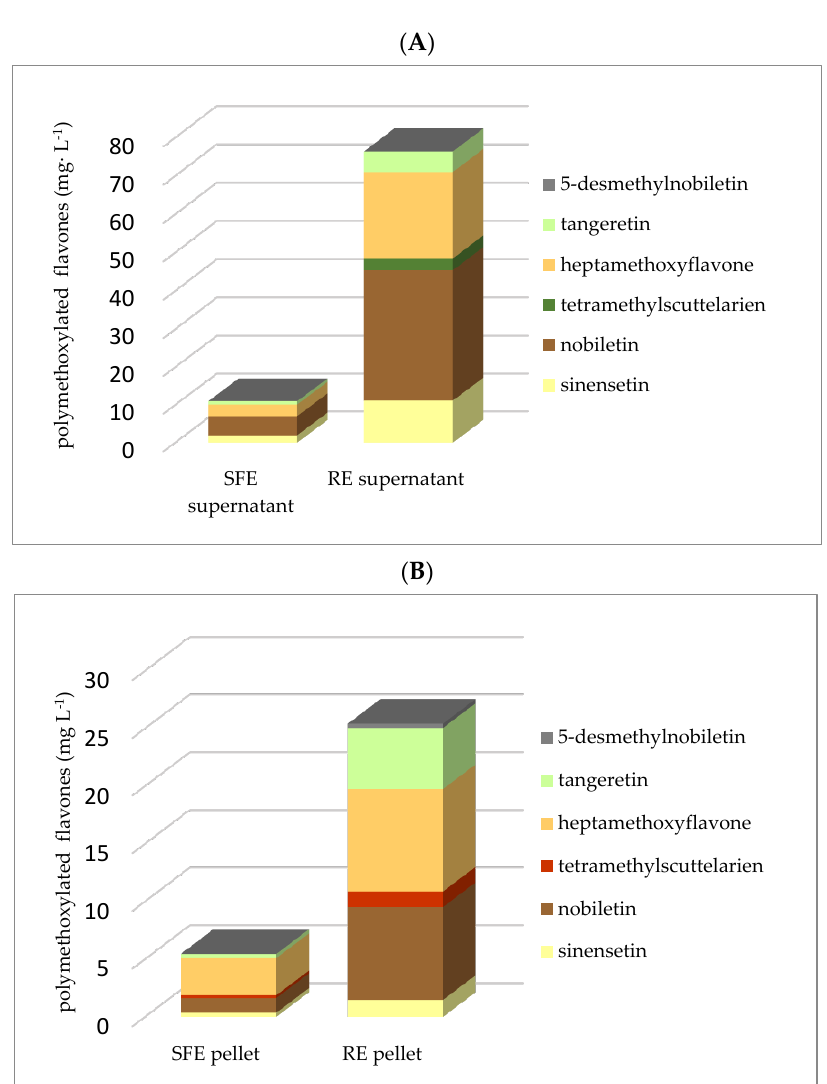
Figure 3. Polymethoxylated flavone content in “Valencia” orange juice processed with shear force extractor (SFE) and reamer extractor (RE) types. ( A ): supernatant; ( B ): pellet.